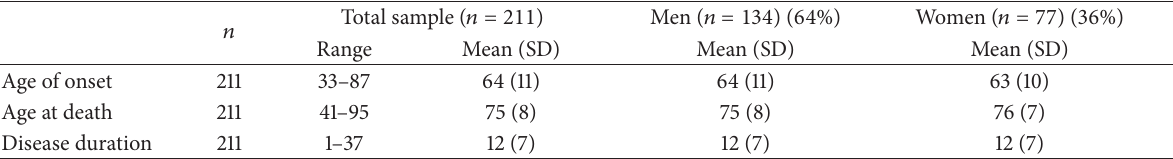
Table 1: Disease characteristics of deceased PD patients.